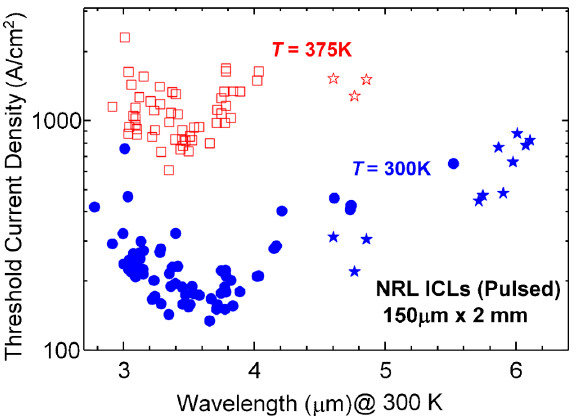
Figure 4. Pulsed threshold current densities vs. emission wavelength (at 300 K) for 85 different broad-area (150 μ m × 2 mm) ICLs with 5,7, and 10 stages that were grown and processed at NRL when operated at 300 K (blue) and 375 K (red). The longer-wavelength devices indicated by stars employed a hybrid bottom cladding, as explained in the text, while the points at the top of the graph represent devices that did not lase at 375